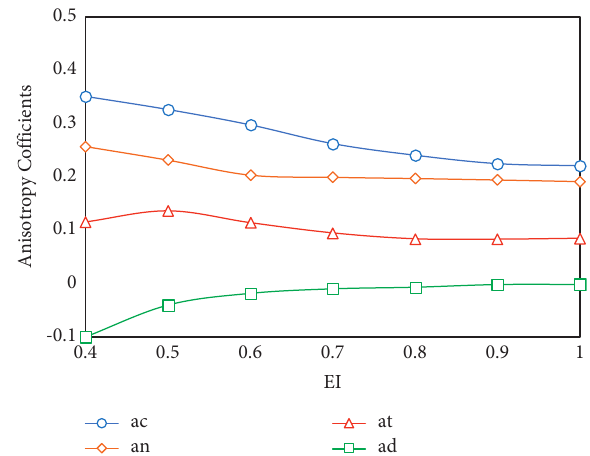
Figure 16: Change curves of the fabric anisotropy coefficients with respect to EI